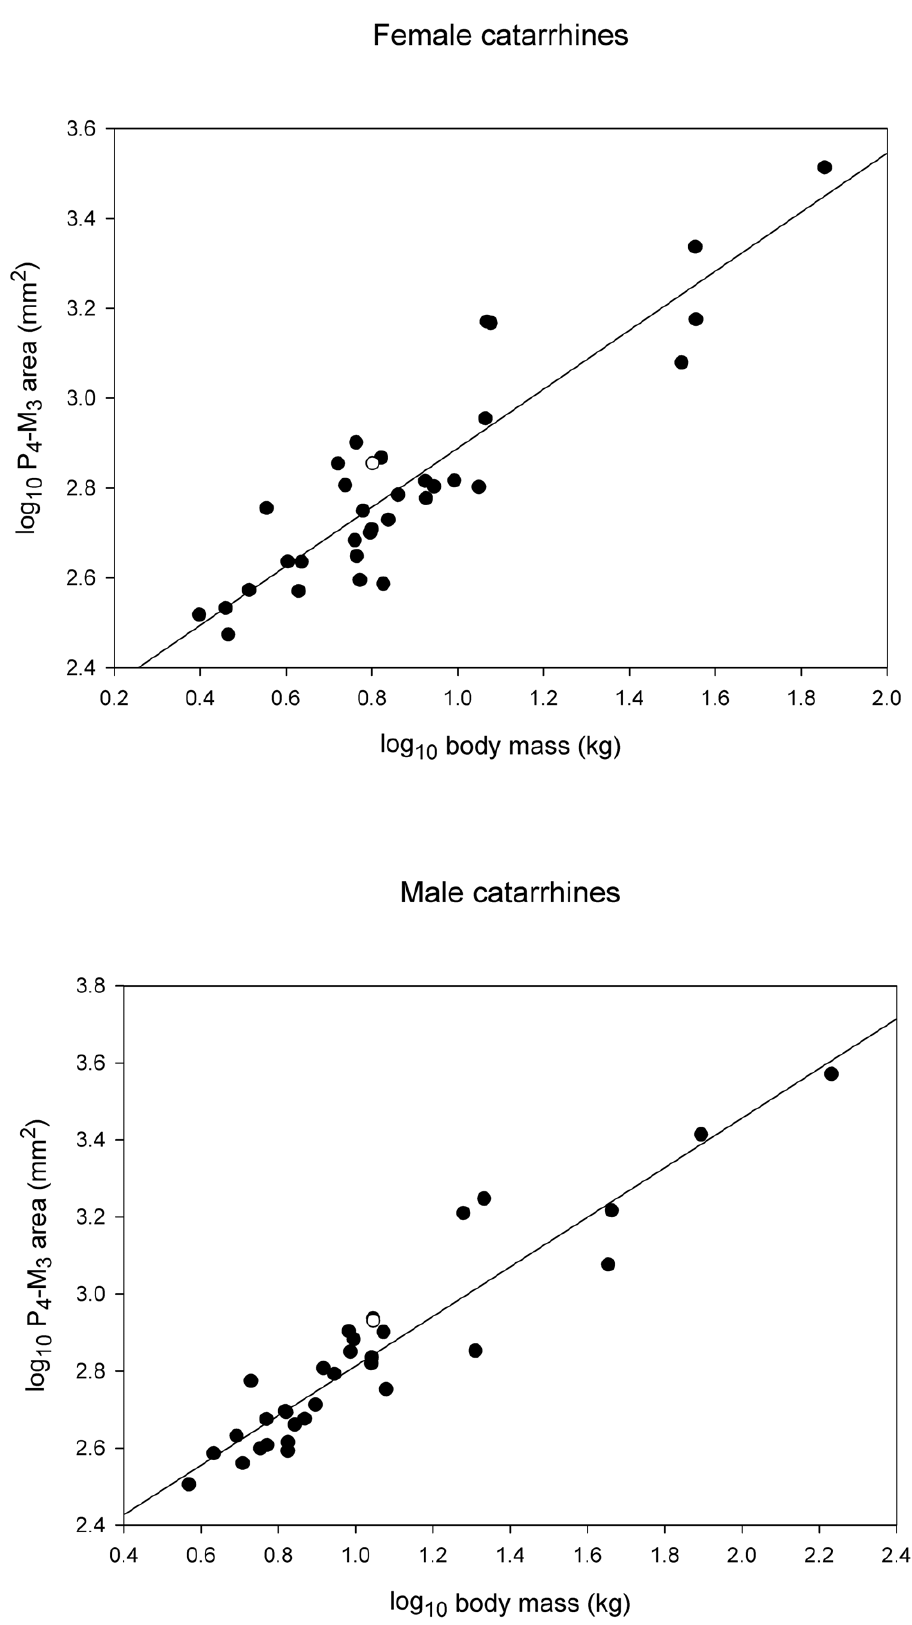
Figure 6. Relative tooth size in catarrhine primates (N=33). Cercocebus atys is represented by open circles. Male and female sooty mangabeys have relatively but not exceptionally large postcanine teeth relative to body size. Tooth area data from ref 19; C. atys was measured from the Taı¨ sample (N=8 females and N=9 males). Body weight data from refs 53,54.